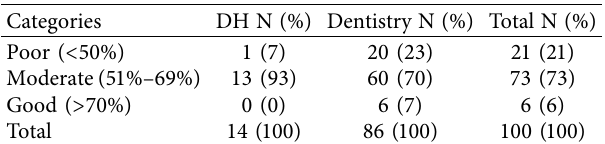
Table 4: The total practical application of ergonomics scores be- tween certain thresholds ( n � 100).